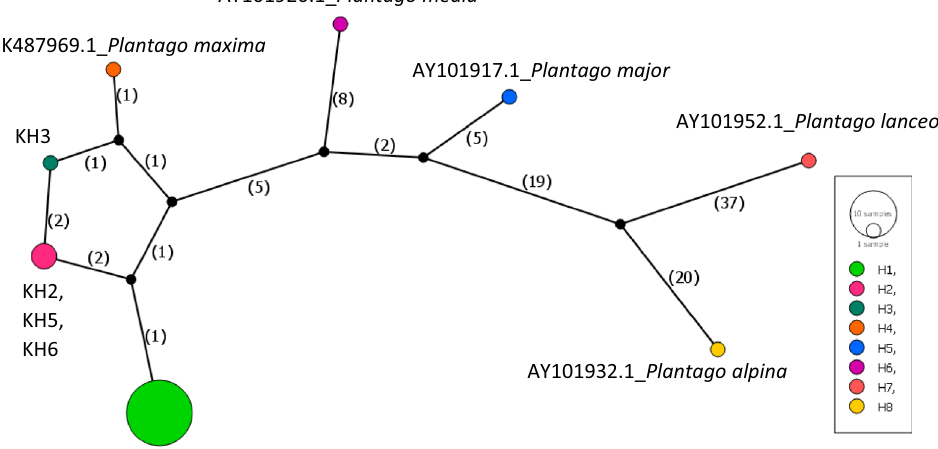
Fig. 11 The haplotype network obtained based on Templeton–Crandall–Singh analysis of the trnL-trnF cpDNA region of Plantago samples. Black dots indicate missing intermediate haplotypes that were not observed in the analyzed sample set. The numbers on branches represent mutation steps (number of base pair changes) between haplotypes. For abbreviation see Table